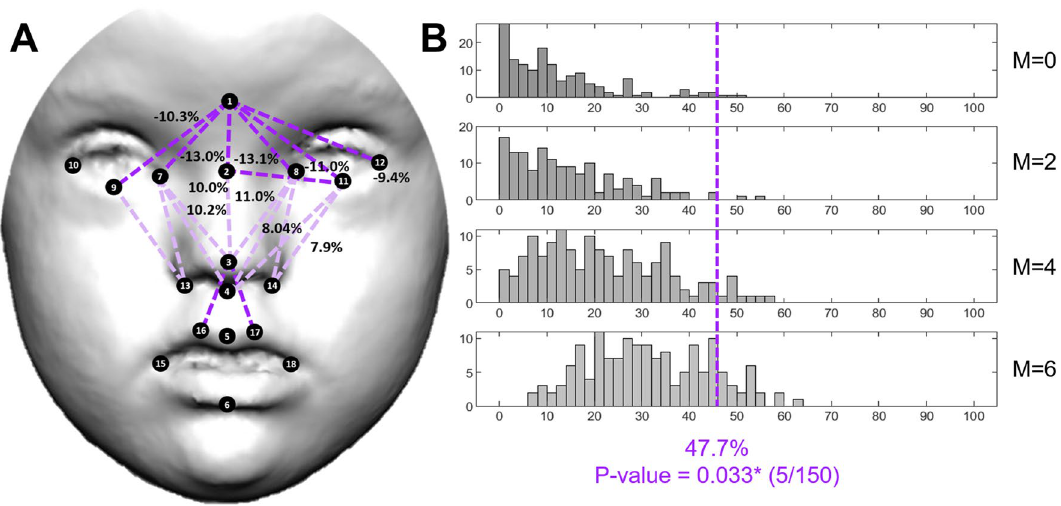
Figure 4. Localized Euclidean Distance Matrix Analysis facial shape pairwise contrasts and iterative bootstrapping tests of facial dysmorphology between controls and individuals diagnosed with Noonan syndrome. From top to bottom histograms, the simulations included 0, 2, 4 and 6 patients. For more details see legend in Fig. 2.